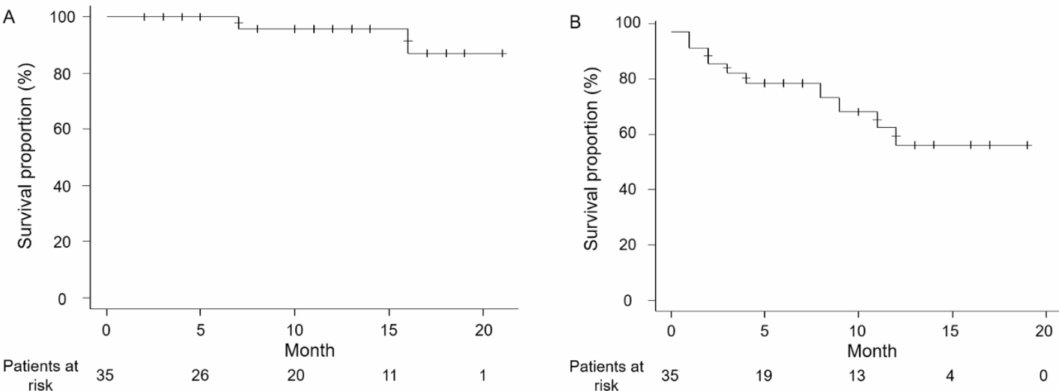
Figure 1. Kaplan–Meier estimates of overall survival (OS) ( A ) and progression-free survival (PFS) ( B ). The OS at 6, 12, and 18 months after nivolumab plus ipilimumab initiation was 100%, 95.8%, and 87.1%, respectively, while the PFS was 78.6%, 56.2%, and 56.2%, respectively.